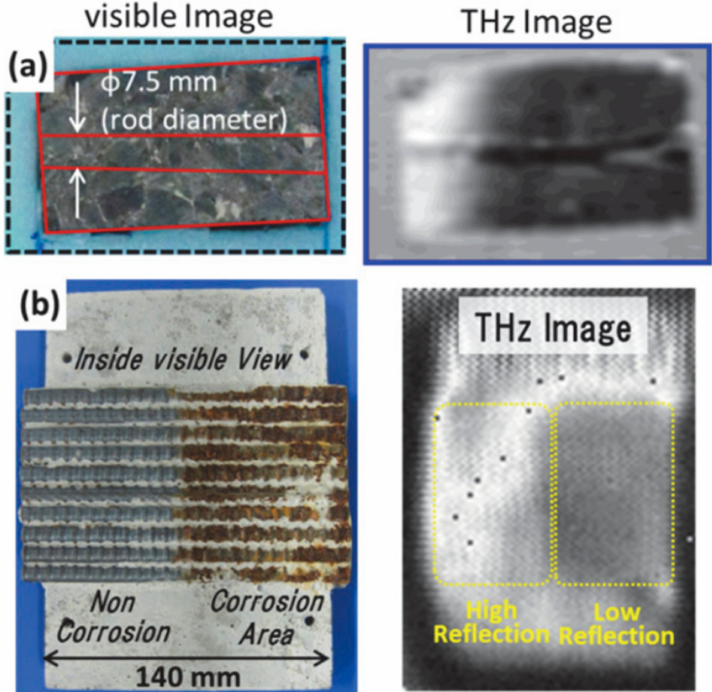
Figure 1. Steel rods inside concrete imaged using THz TDS reflection mode: ( a ) Visible view of the concrete containing a steel rod (left) and the THz image showing the steel rod within (right); ( b ) Cut out view of the concrete showing corroded steel rods and the non-corroded steel rods (left), and the THz image—corroded steel rods produce significantly lower reflection compared to non-corroded steel rods. Reproduced with permission from